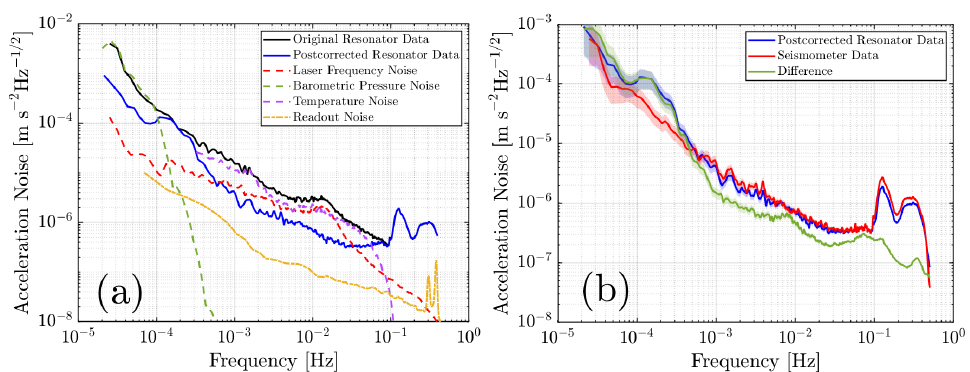
Figure 11. ( a ) The amplitude spectral density of a seismic measurement taken with our optomechan- ical accelerometer alongside the noise contributions from laser frequency fluctuations, barometric pressure, and vacuum chamber temperature. Shown also is the residual after removing all three noise sources, demonstrating a significant reduction in noise from 0.2mHz to 100mHz and below 100µHz. ( b ) A comparison of the postcorrected resonator data to the seismometer data. The good agreement between the two devices now extends down to 1mHz. The shaded areas represent the estimated error bars of the spectra.